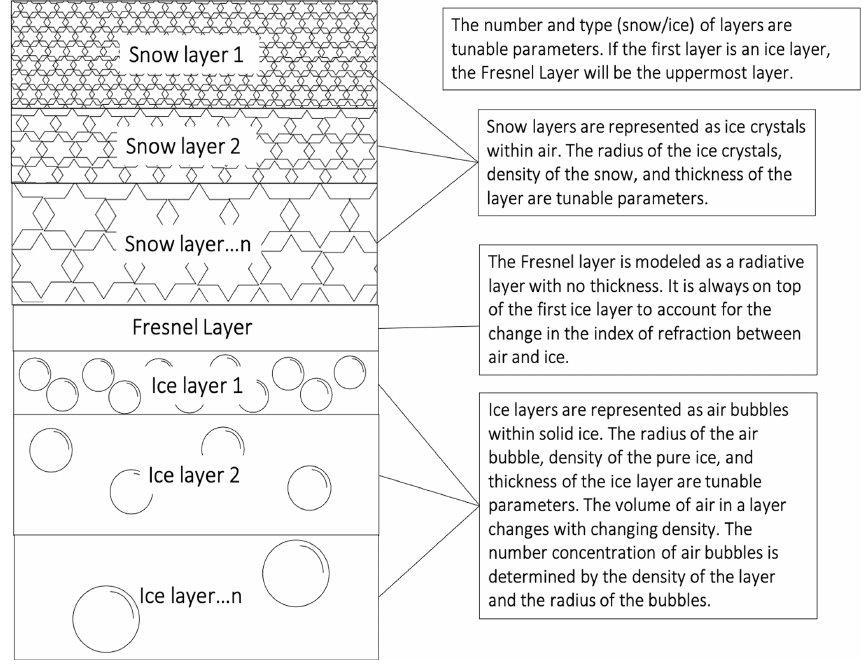
Figure 1. Model schematic of an example column of snow and